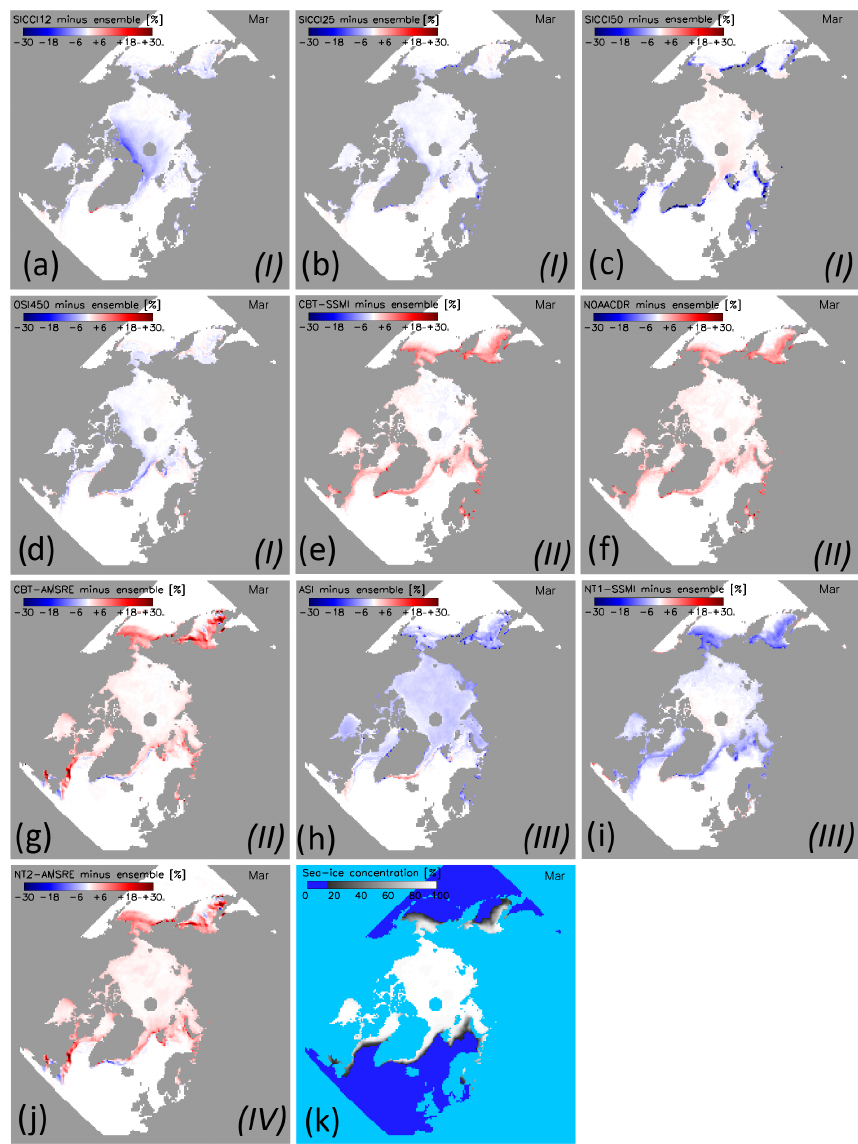
Figure 8. (a–j) Maps of the difference between the multi-annual average monthly SIC of the individual algorithms and the 10-algorithm ensemble median multi-annual average monthly SIC (k) for the Arctic in winter (March) 2003–2011. Differences are only computed for sea-ice concentration of both data sets > 15%. Roman numbers I to IV denote the group assigned to the respective algorithm (see text for